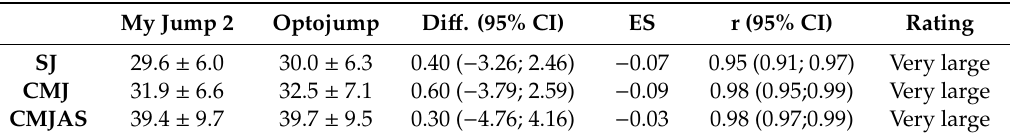
Abbreviations: r, Pearson’s correlation coe ffi cient.